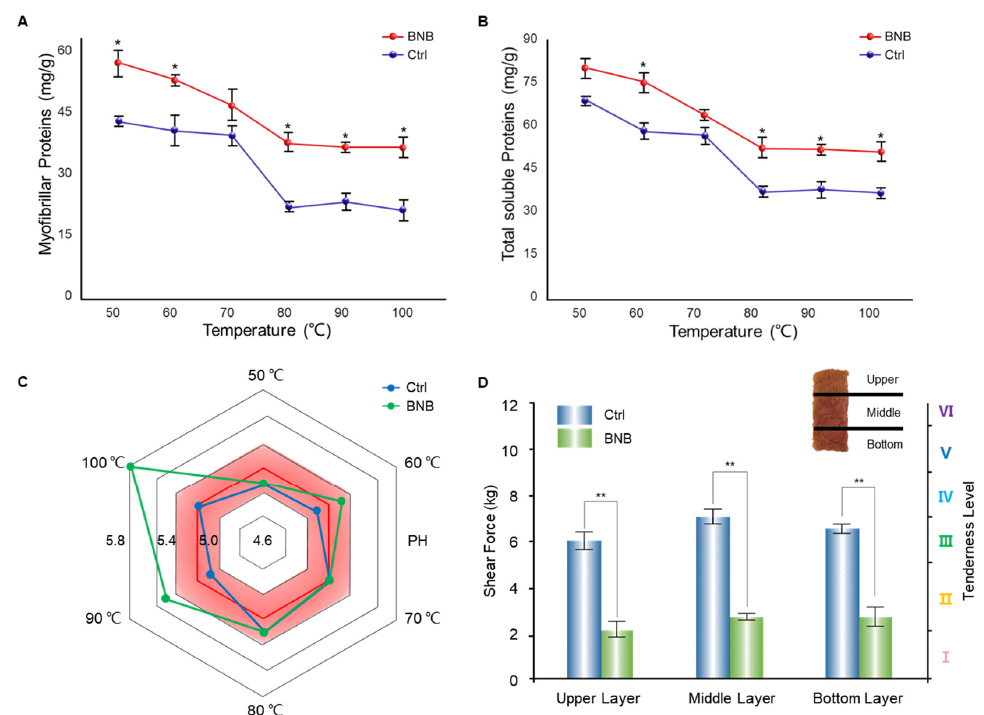
Figure 3. Effect of BNBs on food materials. ( A ) The myofibrillar protein and ( B ) the total soluble protein contents of mutton cooked in different types of water. (* significant difference p < 0.05). ( C ) The pH changes in mutton cooked in different types of water. In the anticlockwise direction, the heating temperature increased from 50 ◦ C to boiling. The ring represents the pH value, which increases from inside to outside. ( D ) Shear force comparison of mutton cooked in different types of water. The mutton cooked in ordinary water and BNB water was cut along the vertical direction of the muscle, and in order to investigate it, three layers (top, middle, and low) were tested, and the corresponding tenderness level is shown in right coordinate. (** significant difference p <